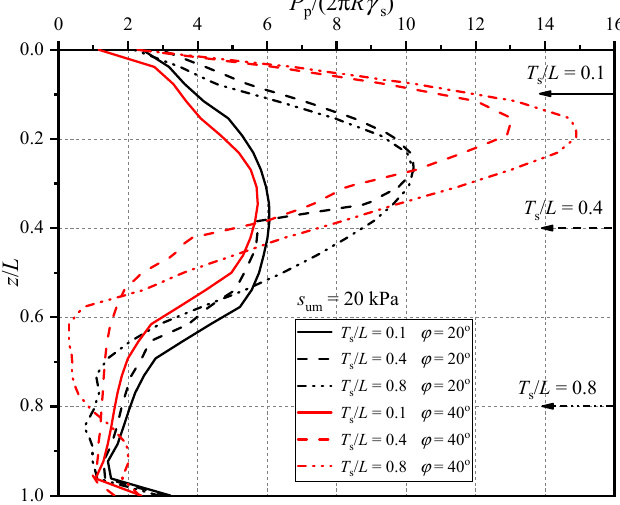
Figure 7. Lateral soil resistance along the pile under different sand layer thicknesses.